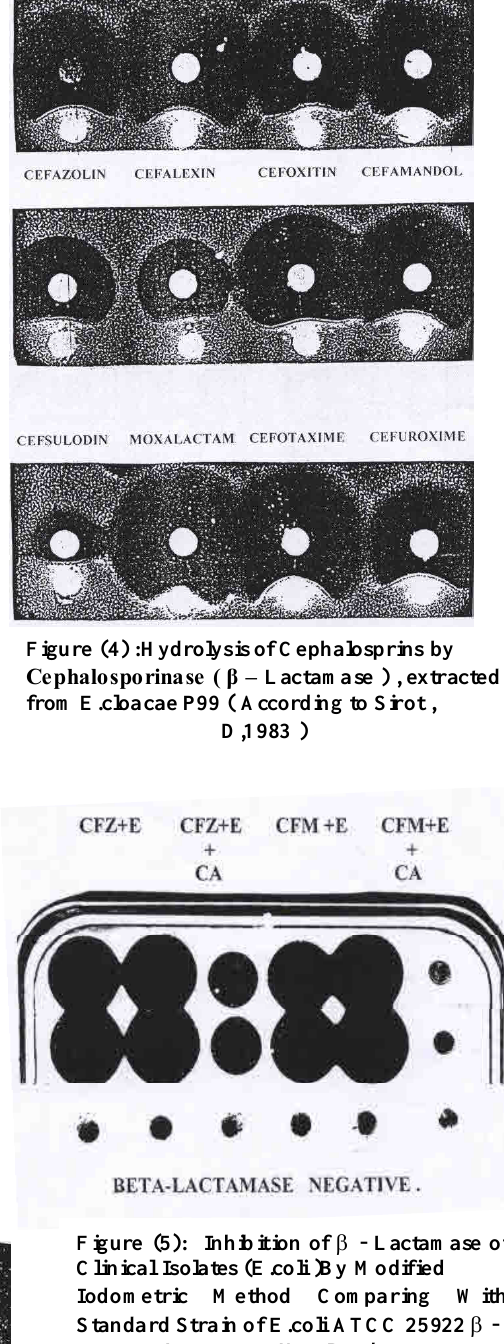
Figure (5): Inhibition of  - Lactamase of Clinical Isolates (E.coli )By Modified Iodometric Method Comparing With Standard Strain of E.coli ATCC 25922  - Lactamase Non